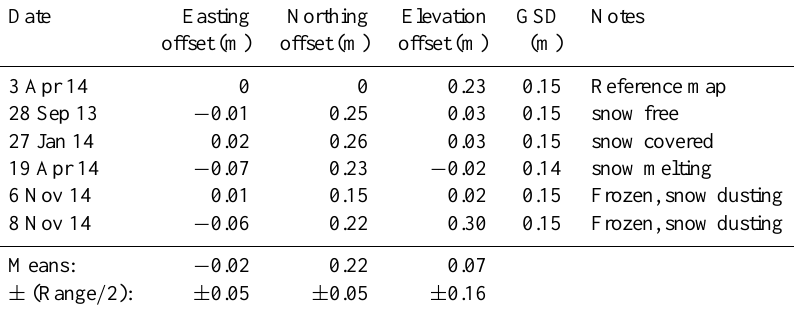
Table 2. Minto Flats accuracy assessment. Values for the reference DEM are geolocation offsets to 21 GCPs. All other values are co- registration offsets of that DEM minus the reference DEM. Statistics at bottom do not include the reference DEM.